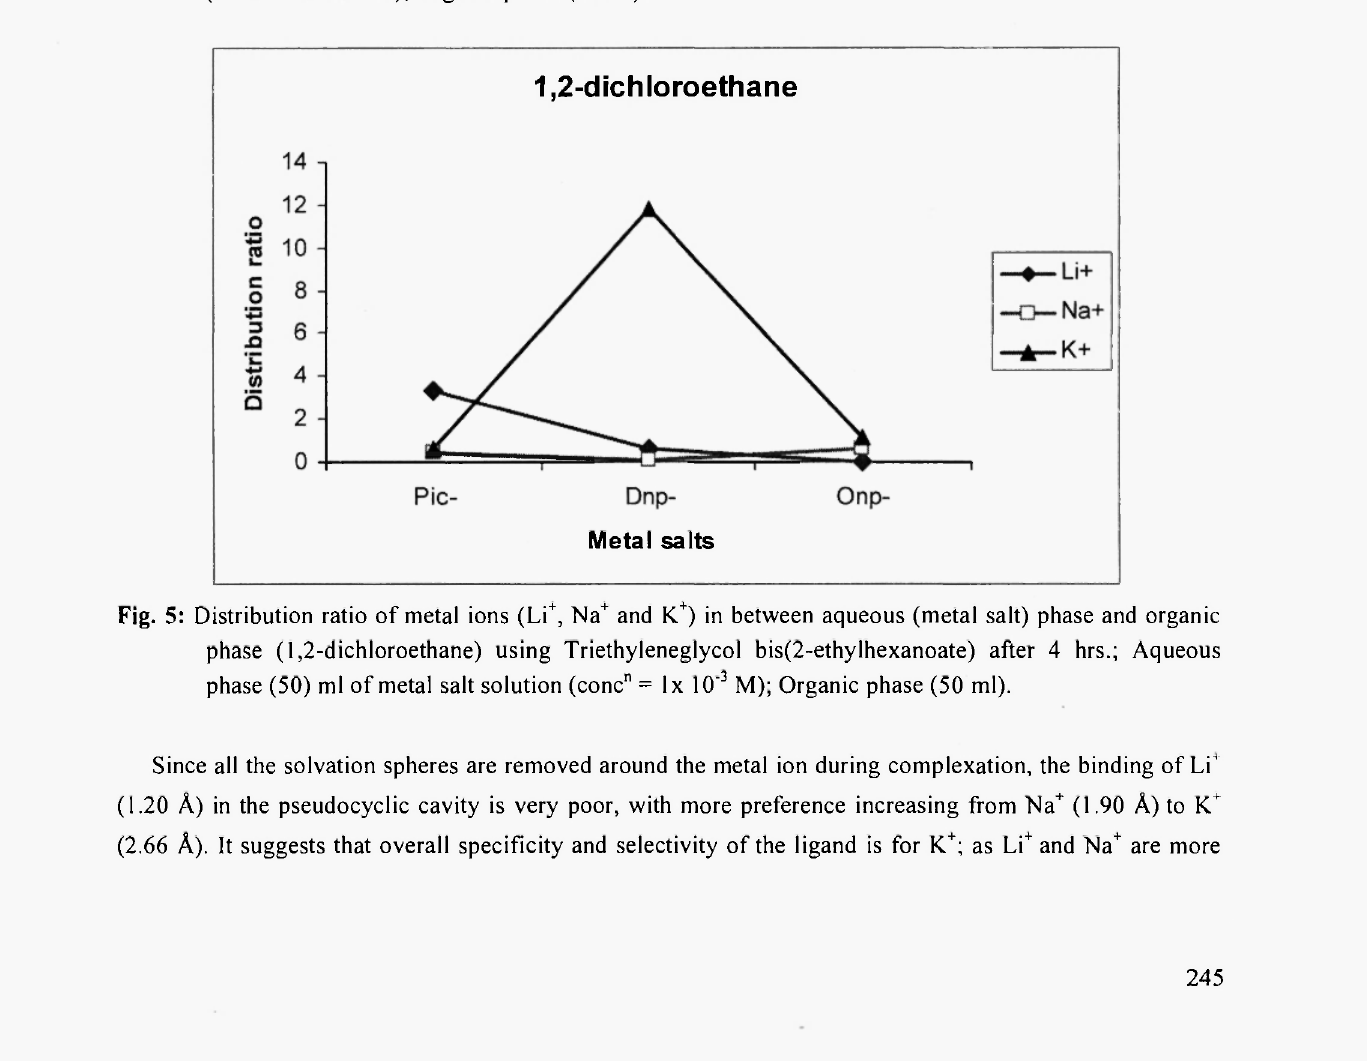
Fig. 4: Amount of cation extracted by ionophore Triethyleneglycol bis(2-ethylhexanoate) across 1,2-dichloroethane, chloroform and carbontetrachloride membranes using metal (Li + , Na + and K + ) orthonitrophenolates after 4 hrs; Aqueous phase (50) ml of metal orthonitrophenolate salt solution (conc" = lx 10" 3 M); Organic phase (50 ml).